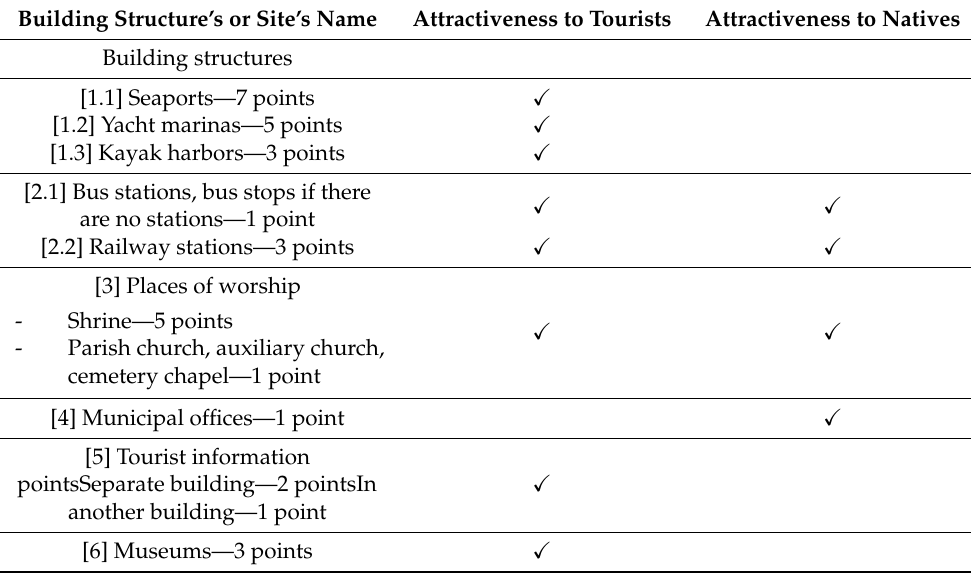
Table 3. The list of iconic building structures and sites with their assigned scores and identification of the nature of the